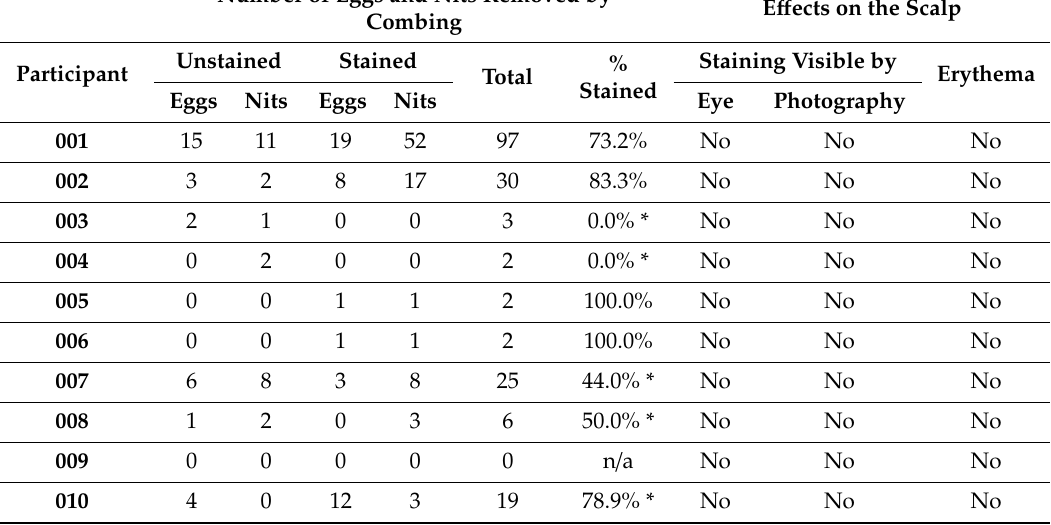
Table 3. Field study of Paranix Eggs Locator Gel: E ff ectiveness of staining of egg and nits, and scalp observations for staining.